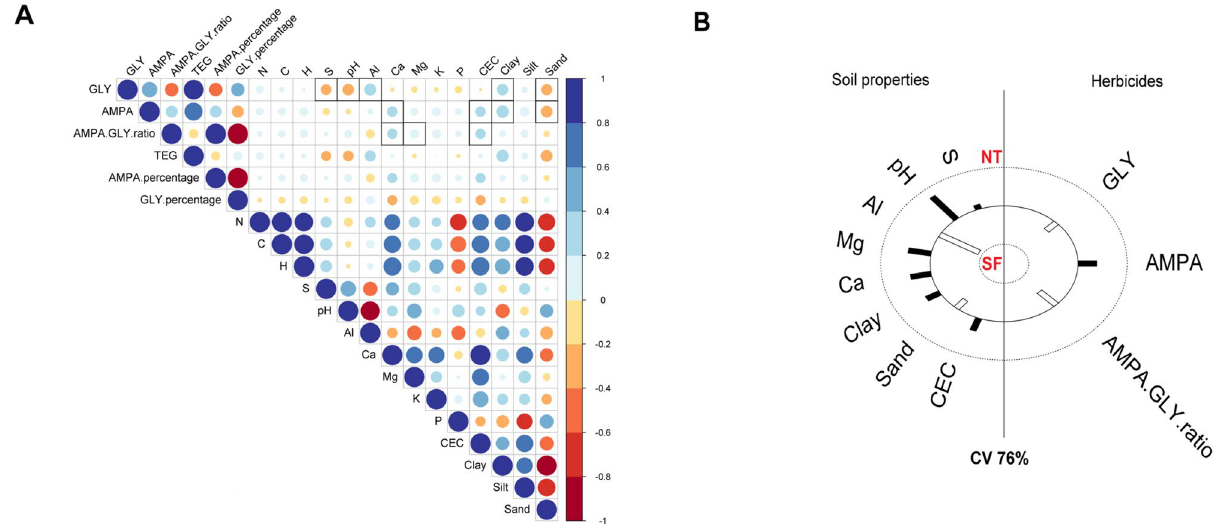
Figure 2. Linear regression between pesticide values and soil properties. ( A ) Correlogram showing the relationship among physical–chemical soil properties and GLY and AMPA values. Positive correlations are displayed in blue and negative correlations in red color. Color intensity and the size of the circle are proportional to the correlation coefficients. ( B ) Canonical variation (%) of the principal axis on canonical correlation analysis among soil properties and pesticides values using the significant correlate parameters. NT no-tillage farms, SF secondary